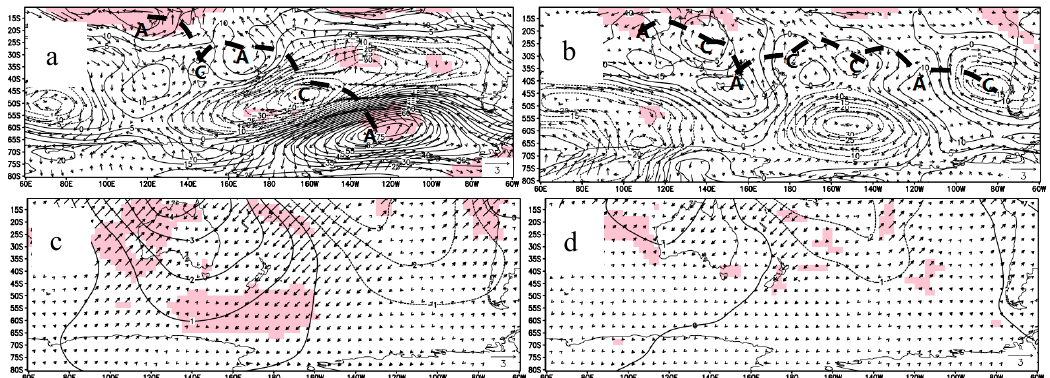
Figure 5. Composites of anomalies of ( a ) 700-hPa horizontal wind (units: m · s − 1 ) and 500-hPa geopotential height (contours; units: gpm; the contour interval is 5 gpm) and ( c ) 200-hPa velocity potential (contours; units: 10 6 m 2 · s − 1 ; the contour interval is 1 × 10 6 m 2 · s − 1 ); divergent wind (vector; units: m · s − 1 ) during DJF 1980–2017 for austral autumn El Niño events. Panels ( b ) and ( d ) show the same but for winter El Niño events. The wind scale is shown at the bottom of the respective panels. Shaded areas indicate statistical significance at the 95% confidence level, based on the Student’s t -test.